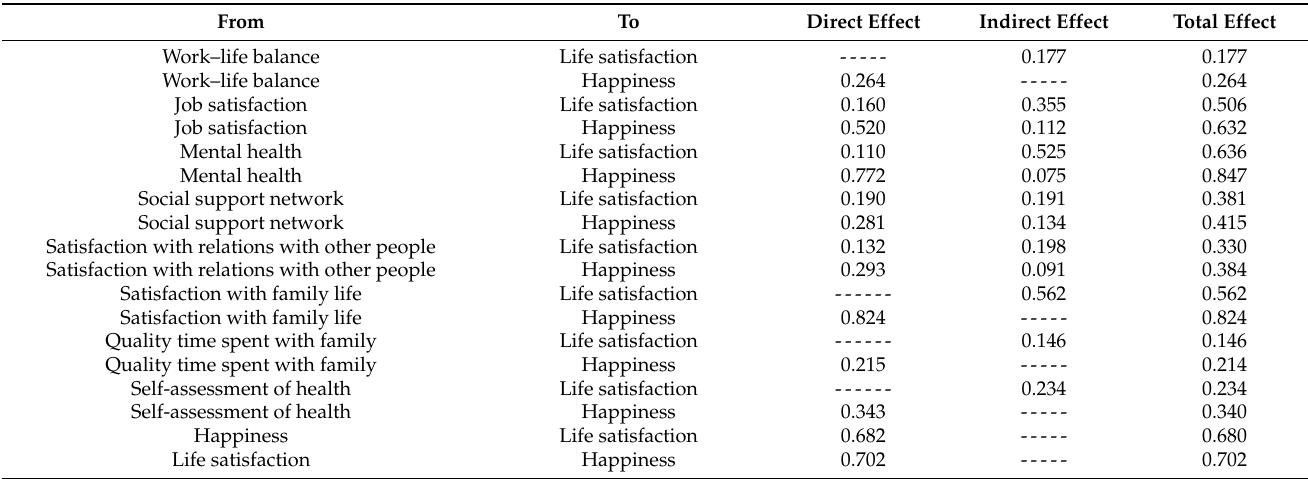
Table 7. Direct and indirect effects in the reciprocal